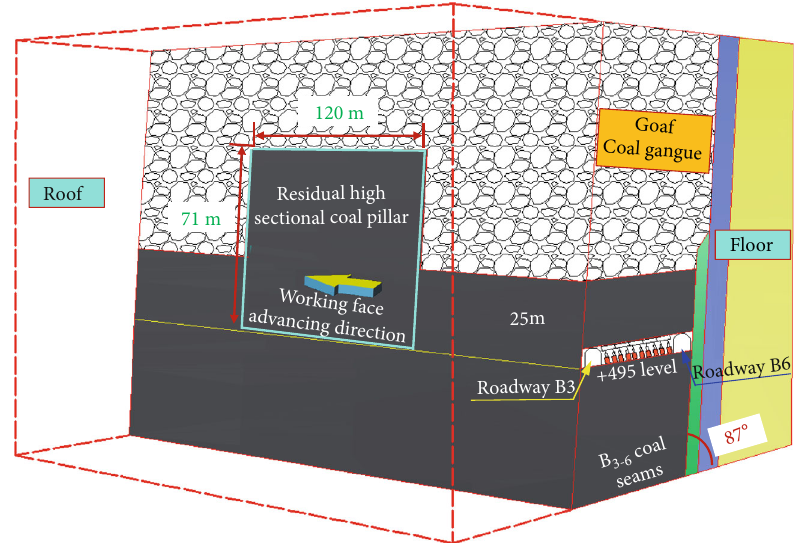
Figure 1: Steeply inclined residual high sectional coal